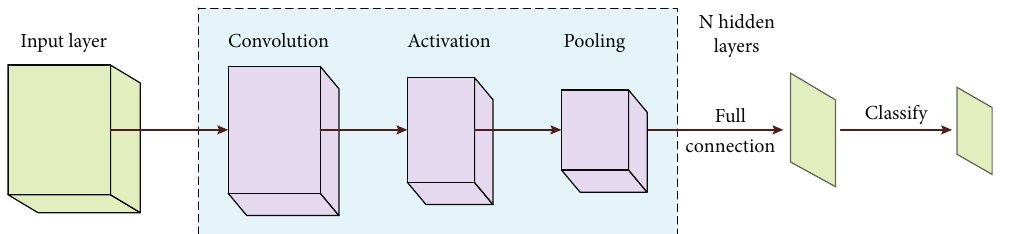
Figure. 1: Convolutional neural network structure diagram.